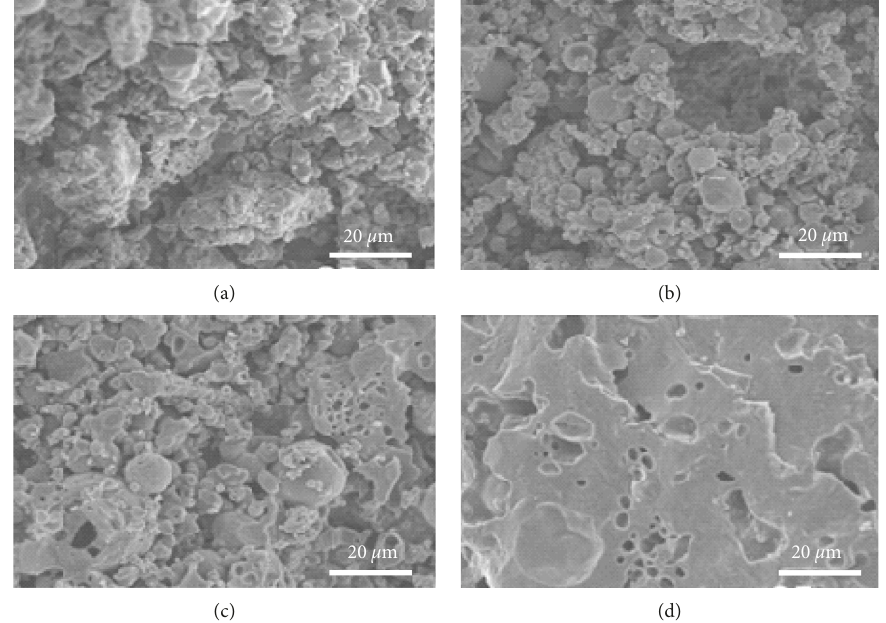
Figure 12: Fracture surface morphology of the sintered samples at (a) 1000 ° C, (b) 1050 ° C, (c) 1100 ° C, and (d) 1150 °